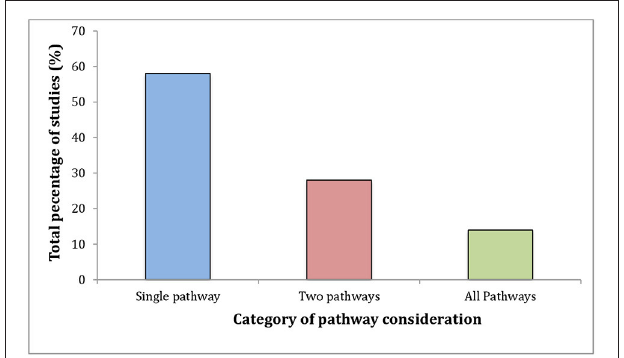
FIGURE 2 | Consideration of the major pathways in host manipulation: Gene/proteomic, neuropharmological and immunological, from 1990 to 2017 in mechanistic studies of host manipulation. Studies were selected using the Web of Science database (search terms: parasite* AND behavior* AND mechanis* AND manipula* OR effect*), and classified based on their consideration of the pathways of host manipulation. To qualify for “consideration,” studies had to either directly address the pathway, or consider it as an alternative hypothesis relative to their original target pathway. 58% ( n = 29) of papers considered a single pathway, while 28% ( n = 14) of studies considered two pathways and only 14% (7) of papers considered all 3 major